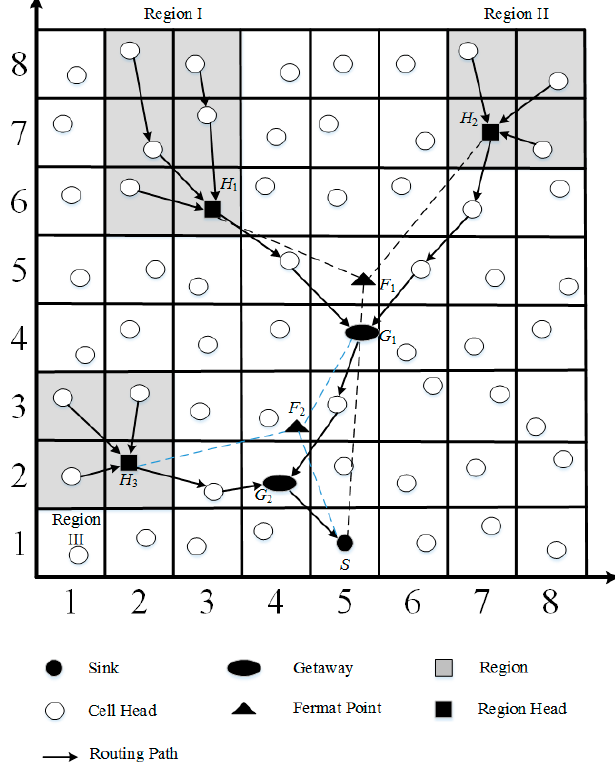
Figure 7. Region head joining.